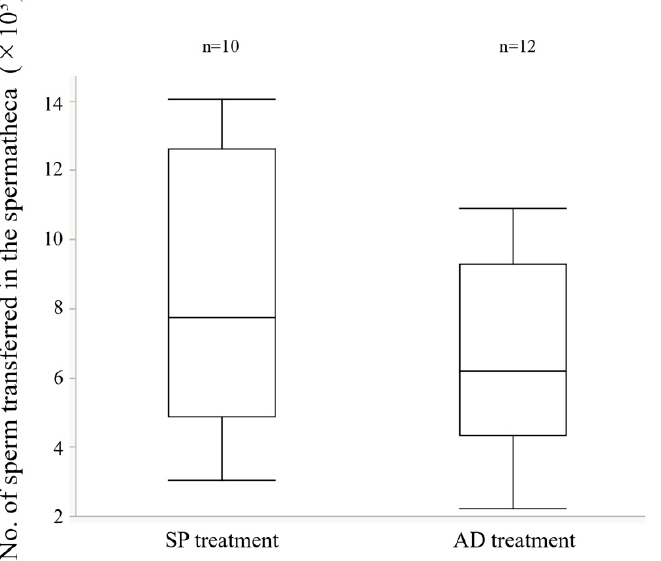
Figure 4. Comparison of the number of sperm transferred into the spermatheca to different treatments. Boxplots represent medians (thick lines), the first and third quartile ranges (box perimeters), and minimum and maximum (whiskers).